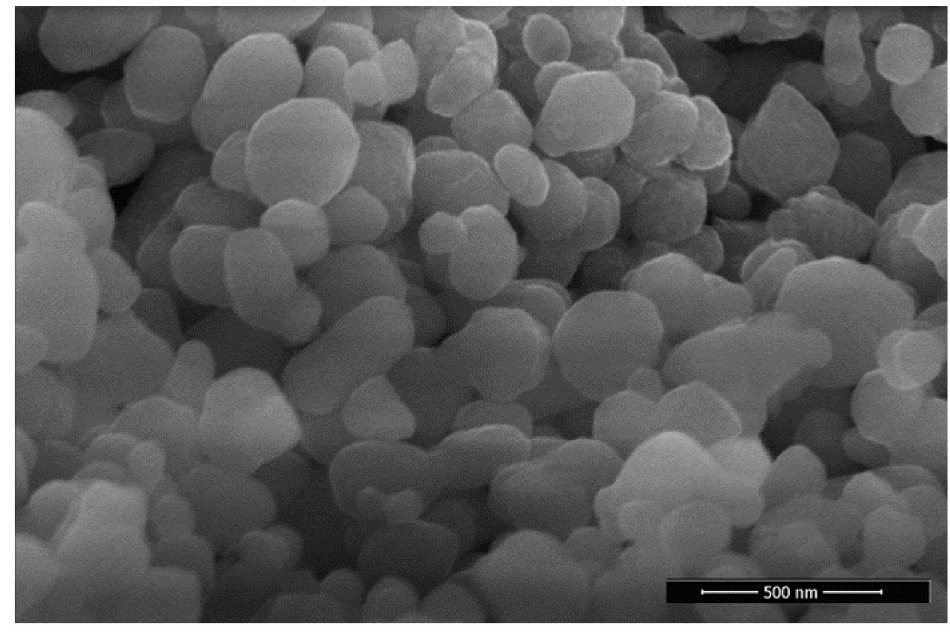
Figure 4. SEM image illustrating NiONPs.